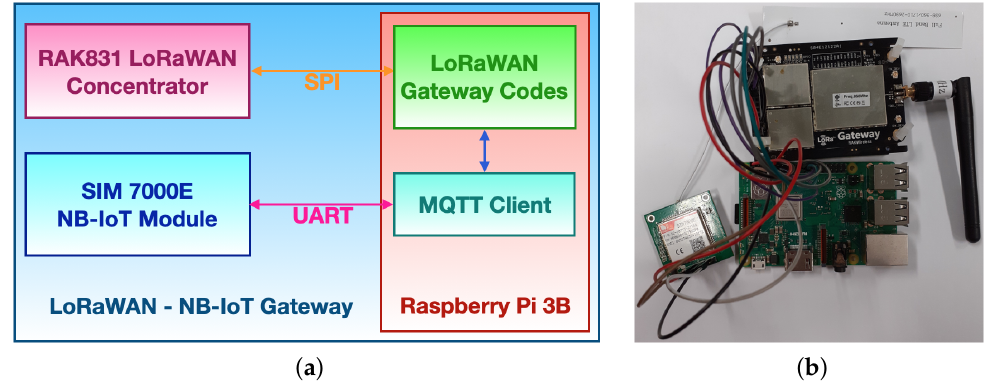
Figure 4. LoRaWAN-NB-IoT Gateway: ( a ) block scheme; ( b ) hardware